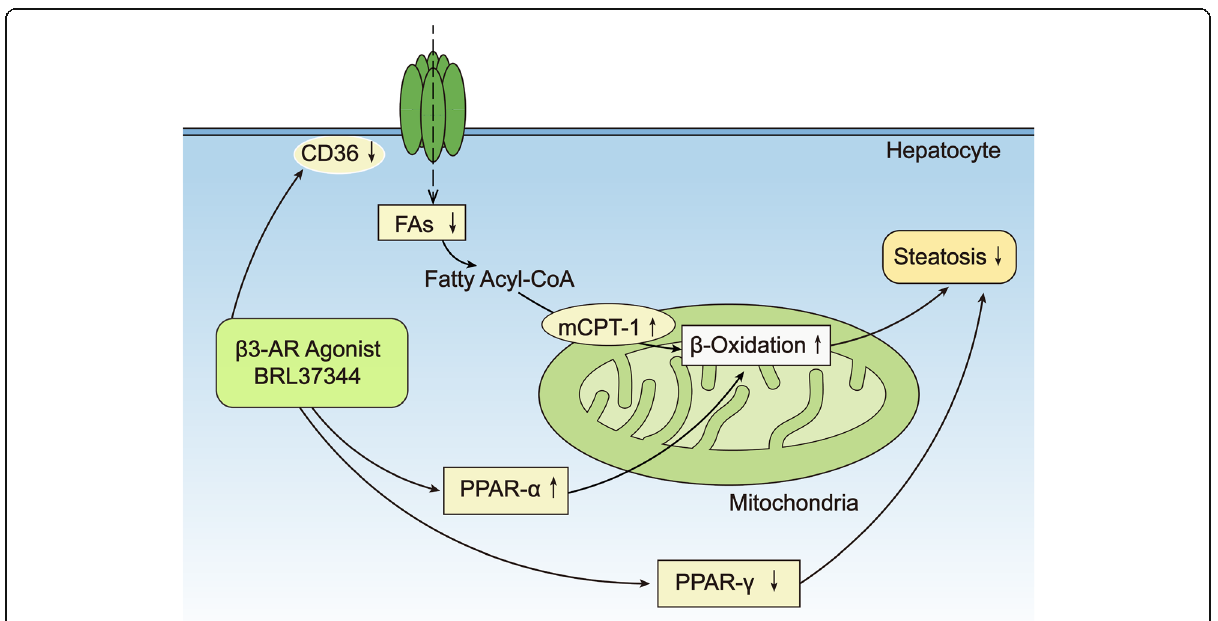
Fig. 5 β 3-AR stimulation plays a role in alleviating liver steatosis associated with NAFLD. Treatment with the β 3-AR agonist BRL37344 for 4 weeks decreased CD36 in NAFLD rats, thus decreasing FAs entry into hepatocytes. On the other hand, increases in mCPT-1 led to increased FAs entry into mitochondria. These two processes together caused a decrease in FA levels in hepatocytes. In addition, the increased FA levels in mitochondria and the increased PPAR- ɑ levels were beneficial for mitochondrial β -oxidation. BRL37344 also decreased PPAR- γ expression. All of the above factors contributed to the relief of liver steatosis in NAFLD rats. β 3-AR: beta-3 adrenergic receptor; FAs: fatty acids;